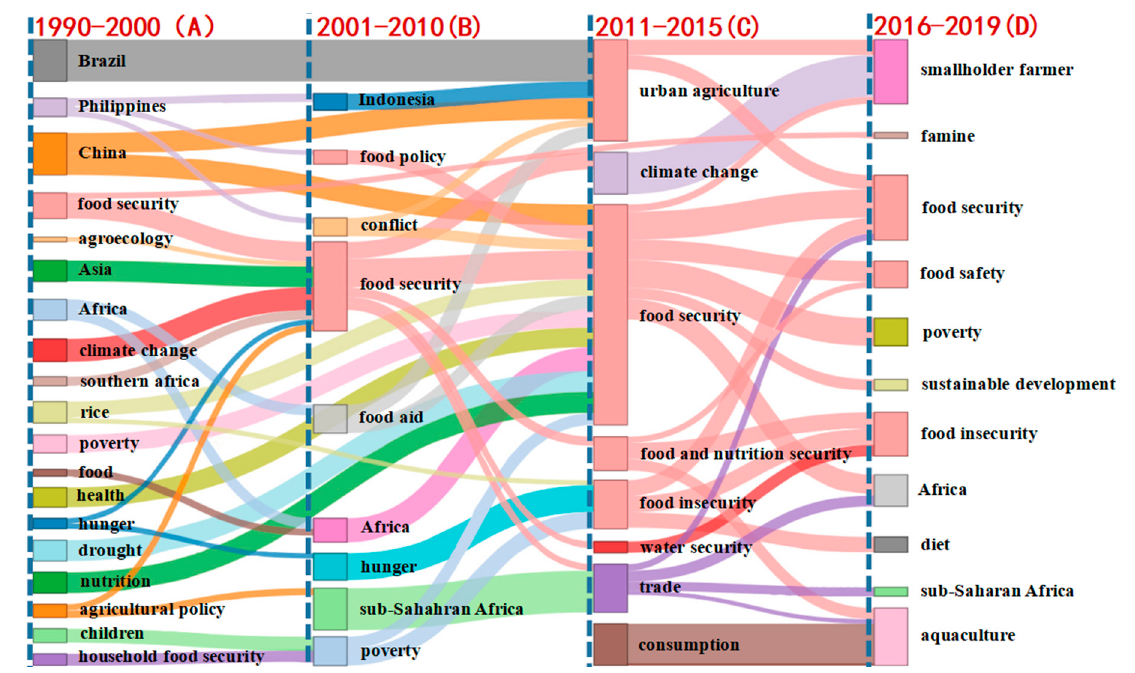
Figure 11. Thematic evolution of the food security research (1990–2019).